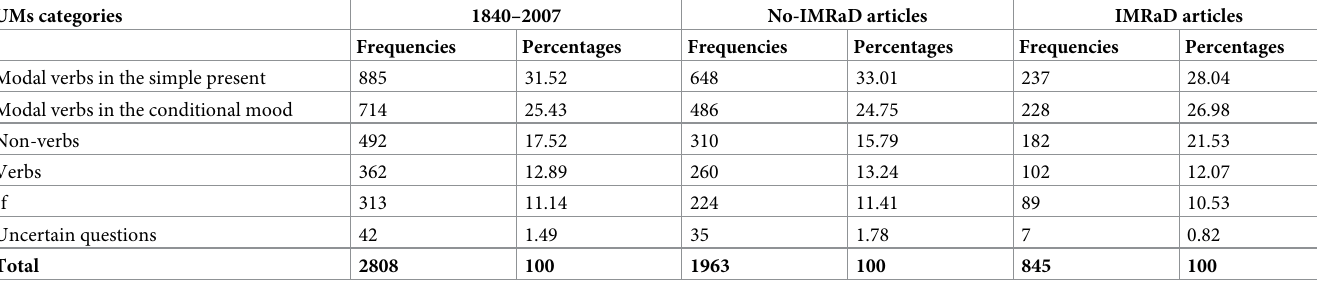
Table 4. Frequencies and percentages of UMs in the BMJ 1840–2007 corpus, and in IMRaD and no-IMRad articles.